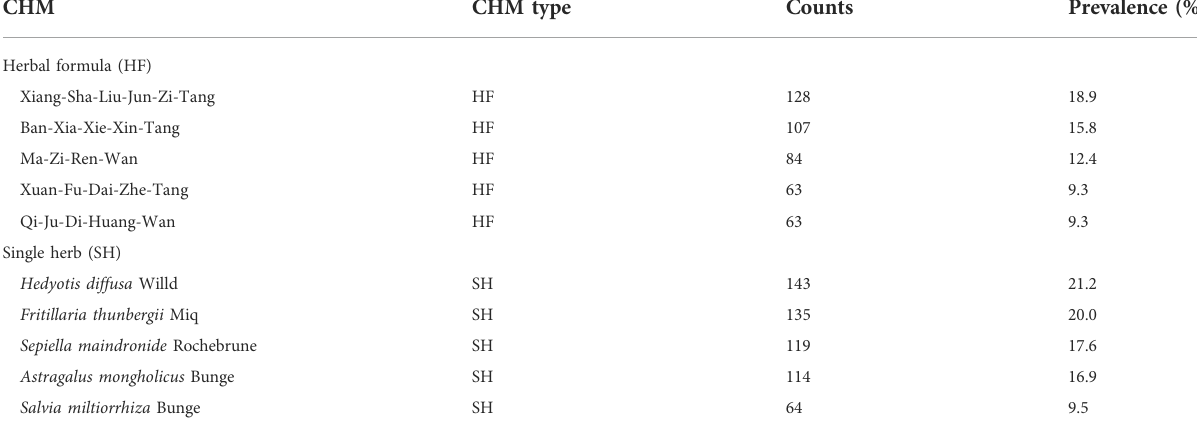
TABLE 3 The top fi ve herbal formula (HF) and single herb (SH) prescribed for stage IV esophageal cancer (prescription number: 676). CHM